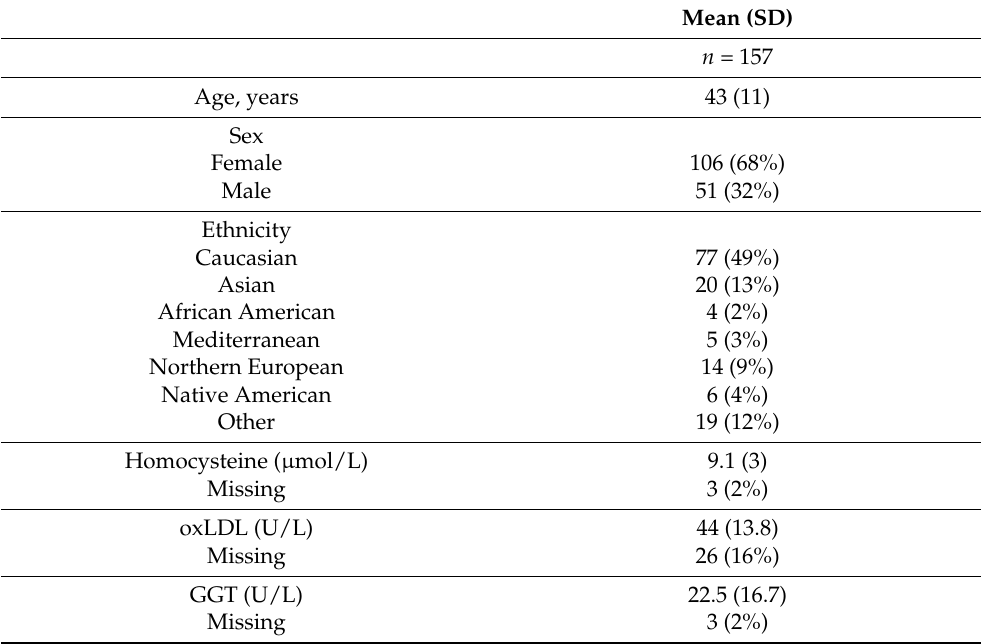
Table 3. Baseline demographics and functional biomarkers.